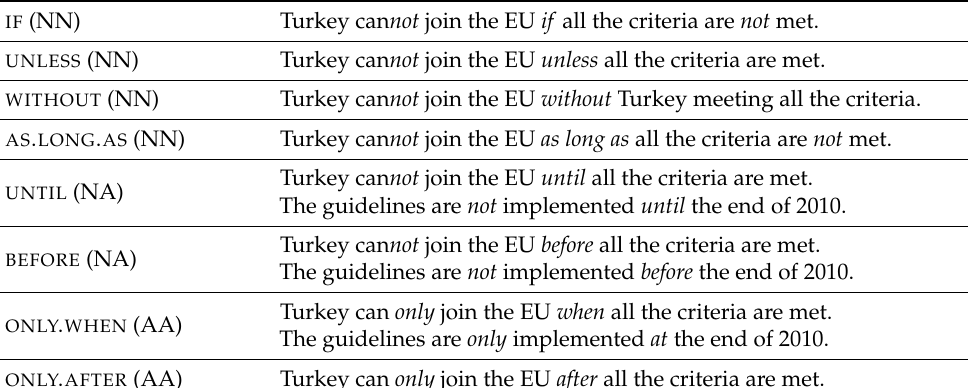
Table 1. Set of paraphrases of not...until in (1) and